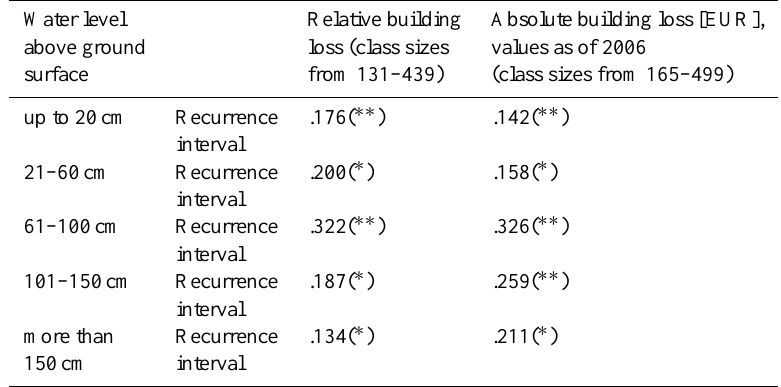
Table 3. Spearman-Rho correlation coefficient for residential building loss and recurrence interval per water level